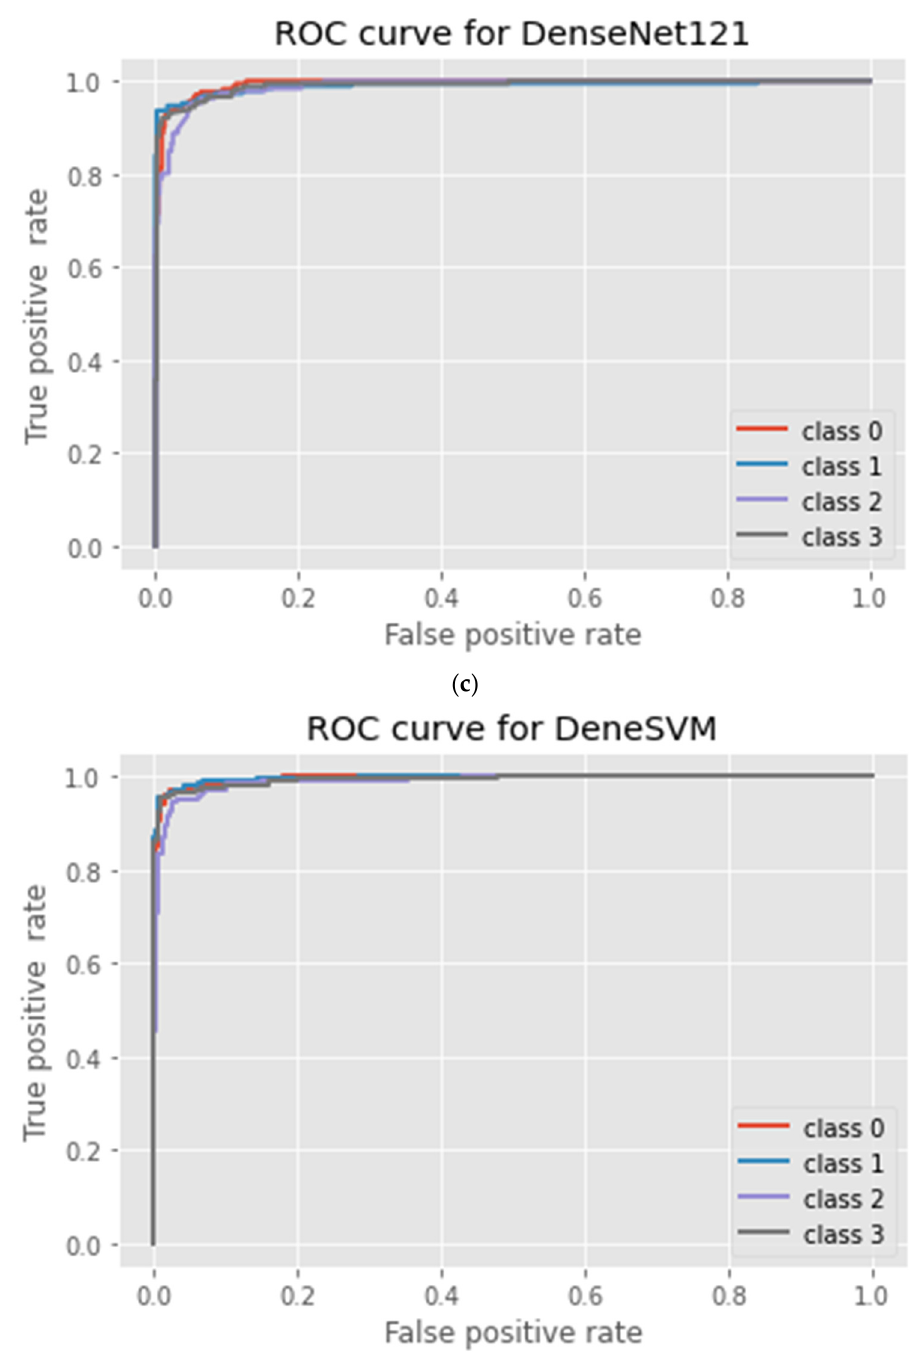
Figure 5 . ROC curve of the DTL models: ( a ) InceptionV3; ( b ) ResNet50V2; ( c ) DenseNet121; and ( d ) proposed DeneSVM .